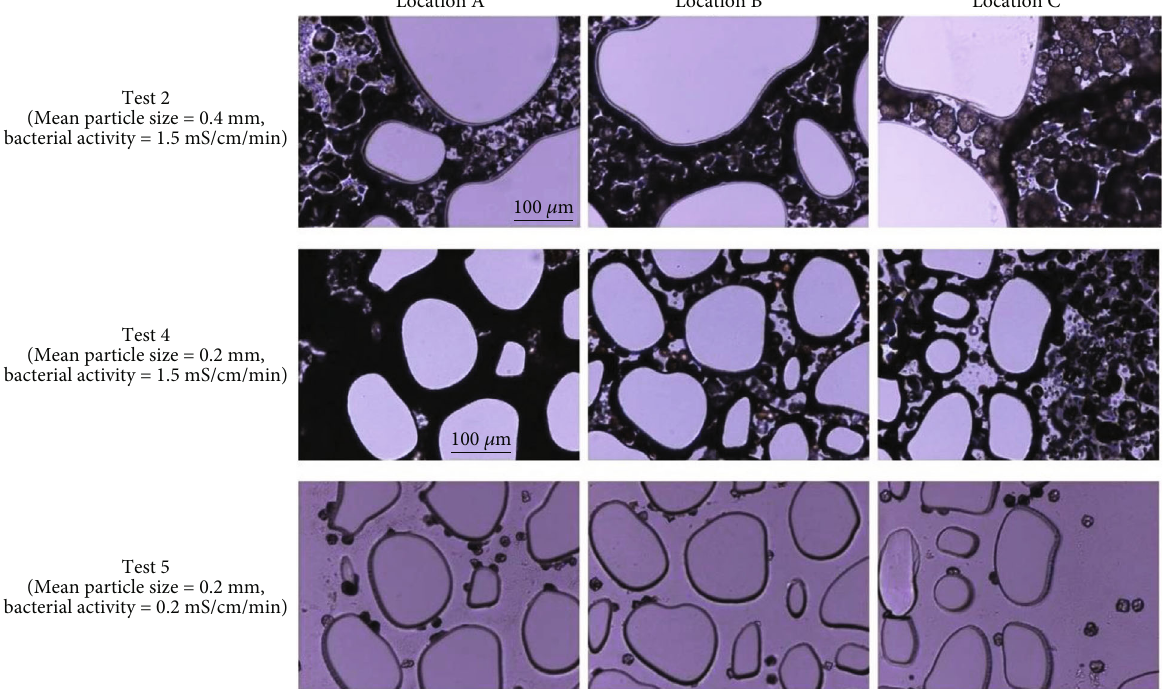
Figure 9: Comparative results of the fi nal treatment e ff ects in Tests 3, 4, and 5 showing the in fl uence of particle size on the MICP